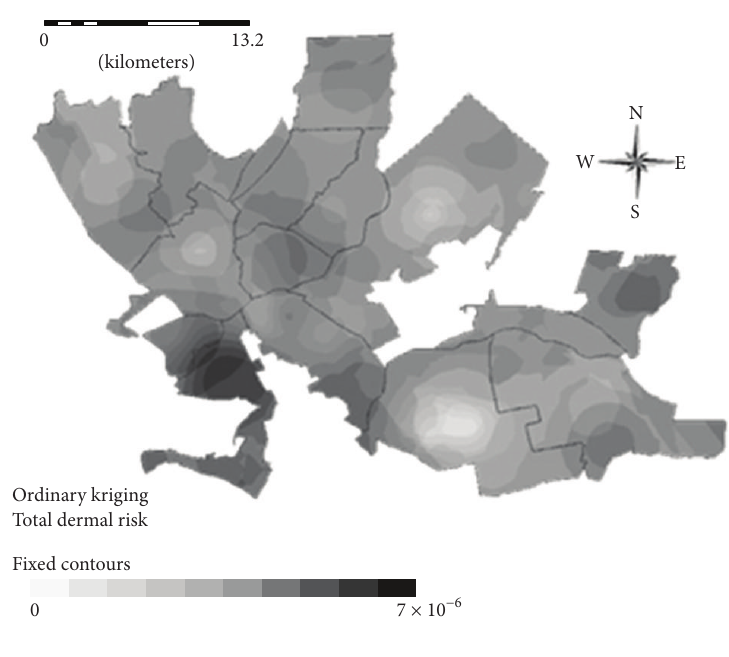
F 5: TTHM cancer risk via dermal